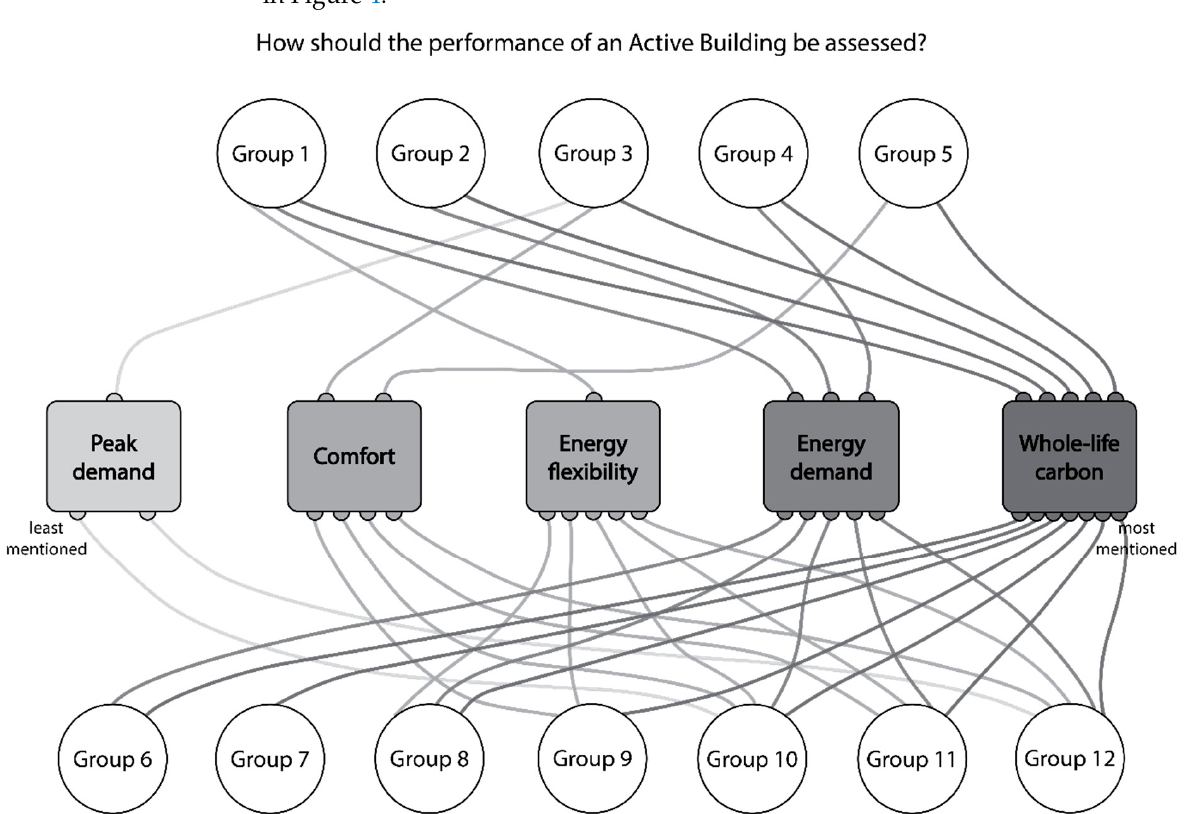
Figure 4. Metrics for assessing the performance of an active building according to different groups of stakeholders.